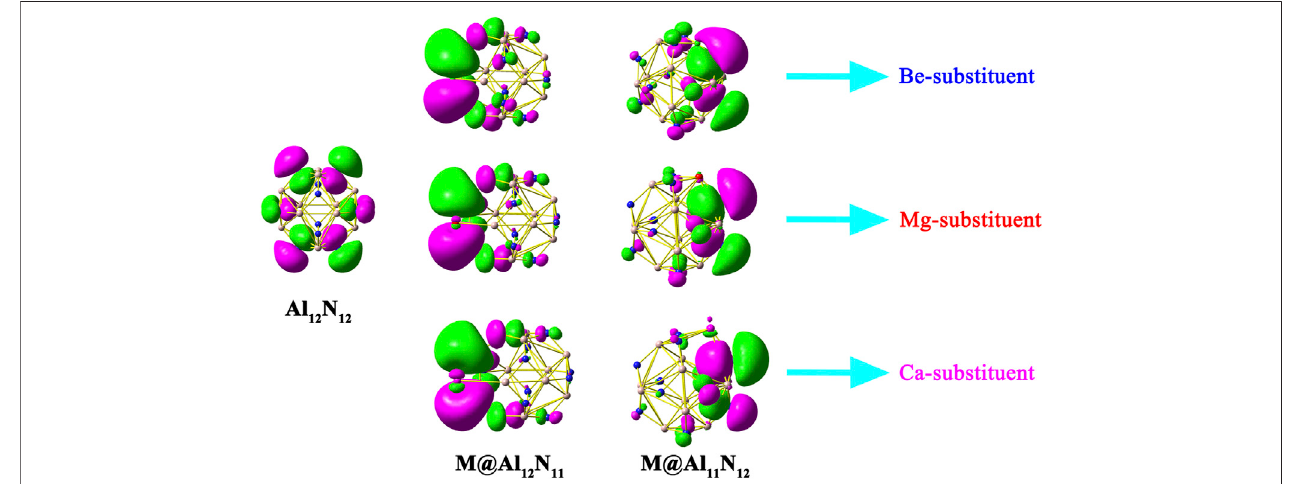
FIGURE 2 | HOMOs of Al 12 N 12 , M@Al 12 N 11 , and M@Al 11 N 12 (M = Be, Mg, and Ca)